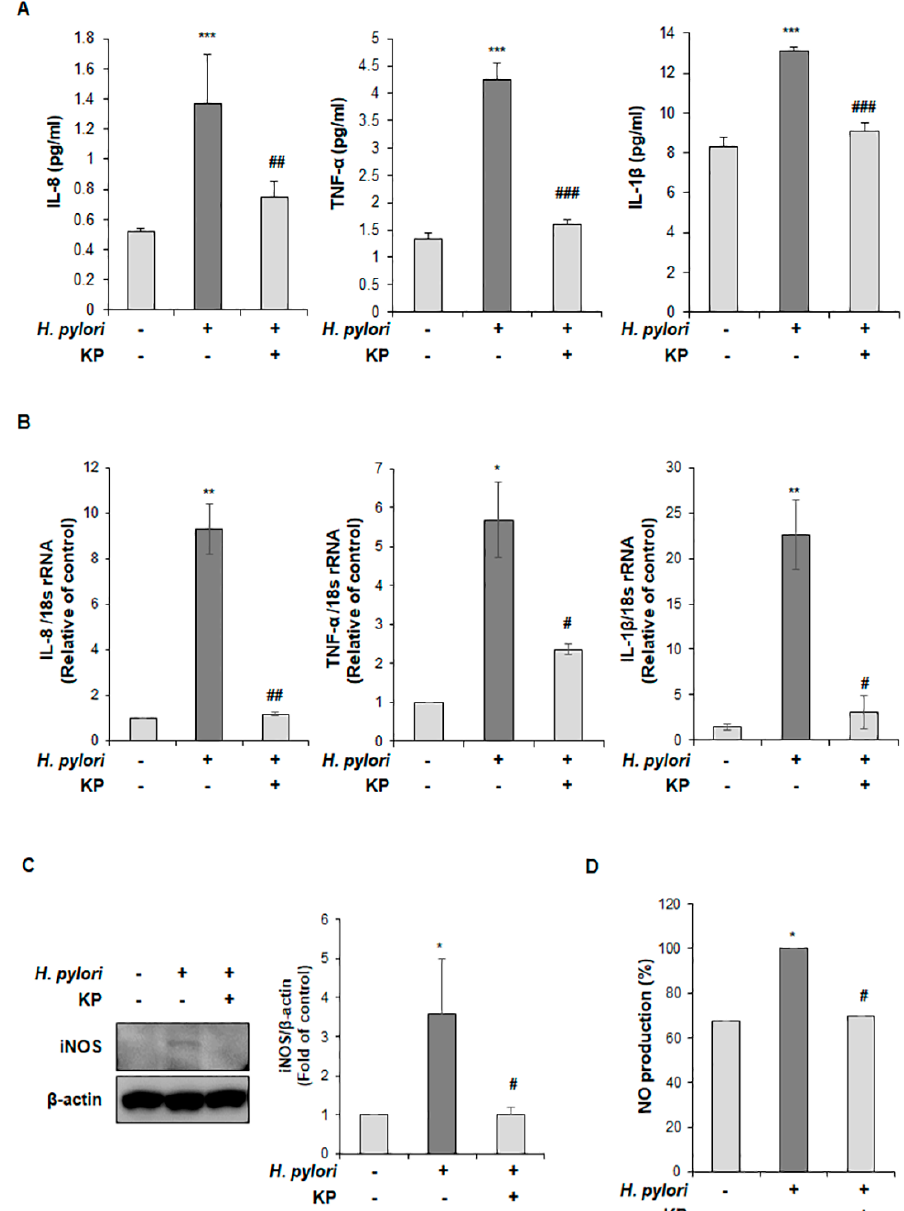
Figure 3. KP inhibits pro-inflammatory response and NO production in H. pylori -infected gastric mucosal injury mice model. ( A ) IL-8, TNF- α , and IL-1 β production levels of pro-inflammatory cytokines were measured in serum via ELISA. ( B ) The mRNA expressions of IL-8, TNF- α , and IL-1 β in gastric mucosal tissues were examined via qRT-PCR. The 18S rRNA was used as an internal control. ( C ) The protein expression of iNOS in gastric mucosal tissues was determined by Western blotting. β -actin was used as an internal control. ( D ) The secretory serum levels were measured for NO production. Data are the mean ± standard deviation ( n = 4). Statistical significance was analyzed by analysis of variance. * p < 0.05, ** p < 0.01, and *** p < 0.001 vs. normal group; # p < 0.05, ## p < 0.01 and ### p < 0.001 vs. H. pylori group, significantly different compared with